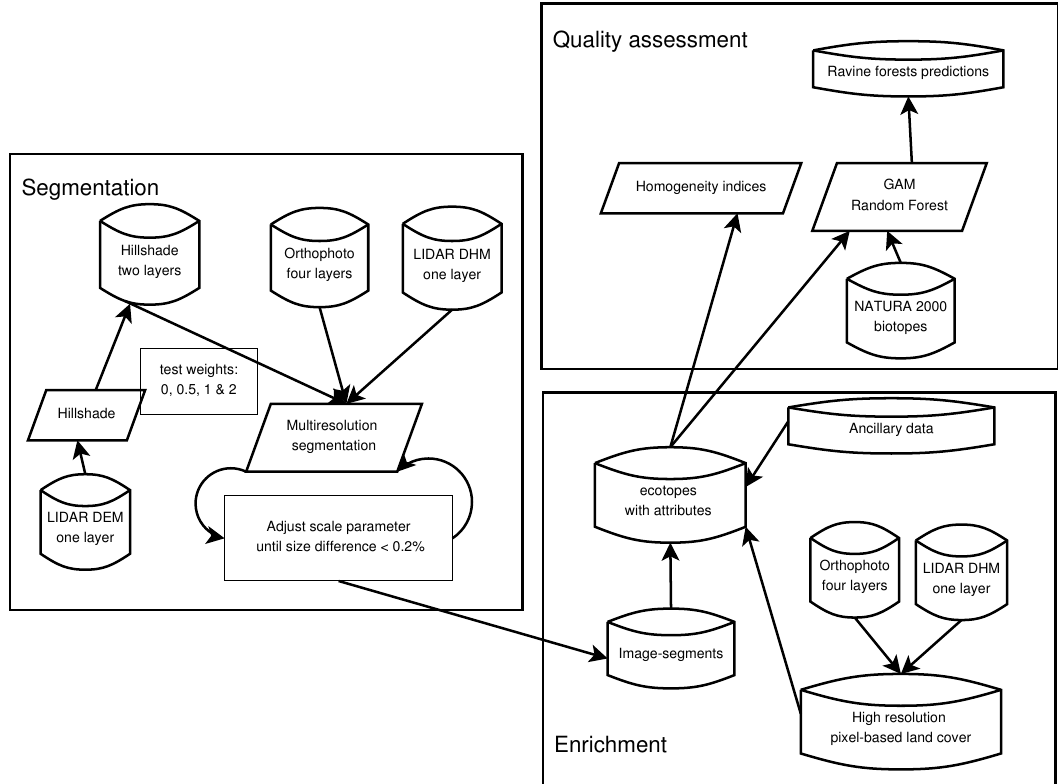
Figure 2. Overall flowchart of the proposed